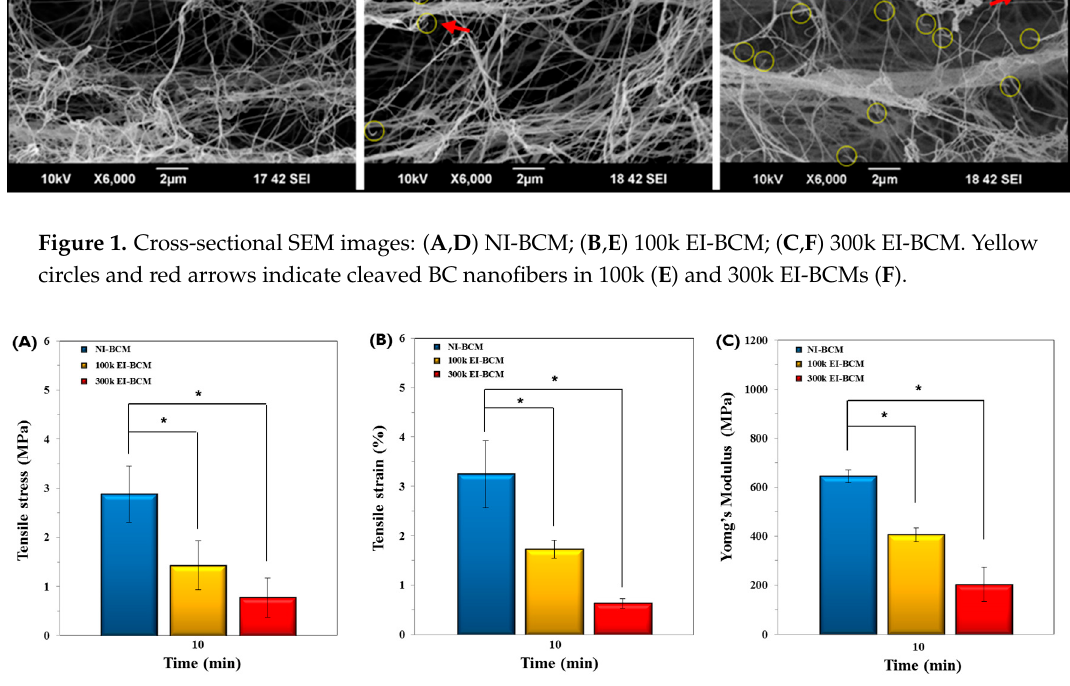
Figure 2. Mechanical properties of BCMs with respect to radiation dose rate after a 10-min soak in water. ( A ) Tensile stress (MPa), ( B ) Tensile strain (%), and ( C ) Young’s modulus (MPa). The mechanical properties of 100k and 300k EI-BCMs were significantly lower than those of NI-BCMs (* p < 0.05).